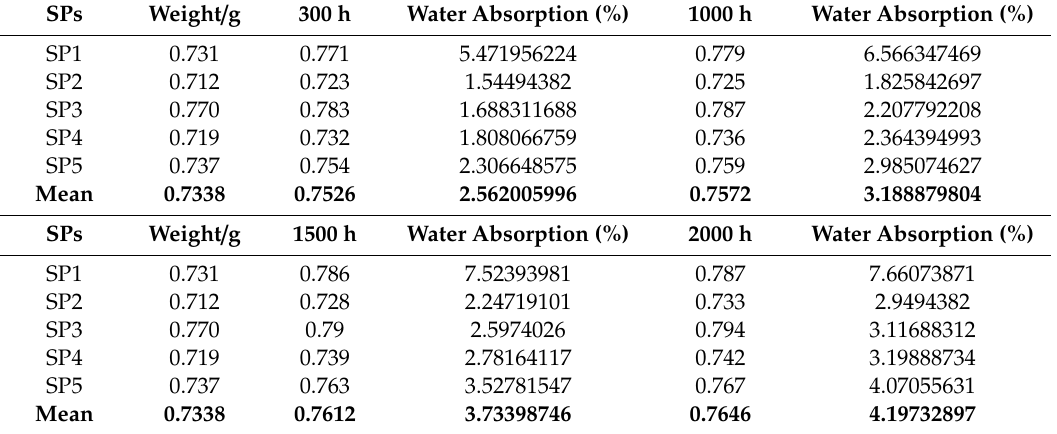
Table 3. Summary of water absorption test results of PVDF–SSPF